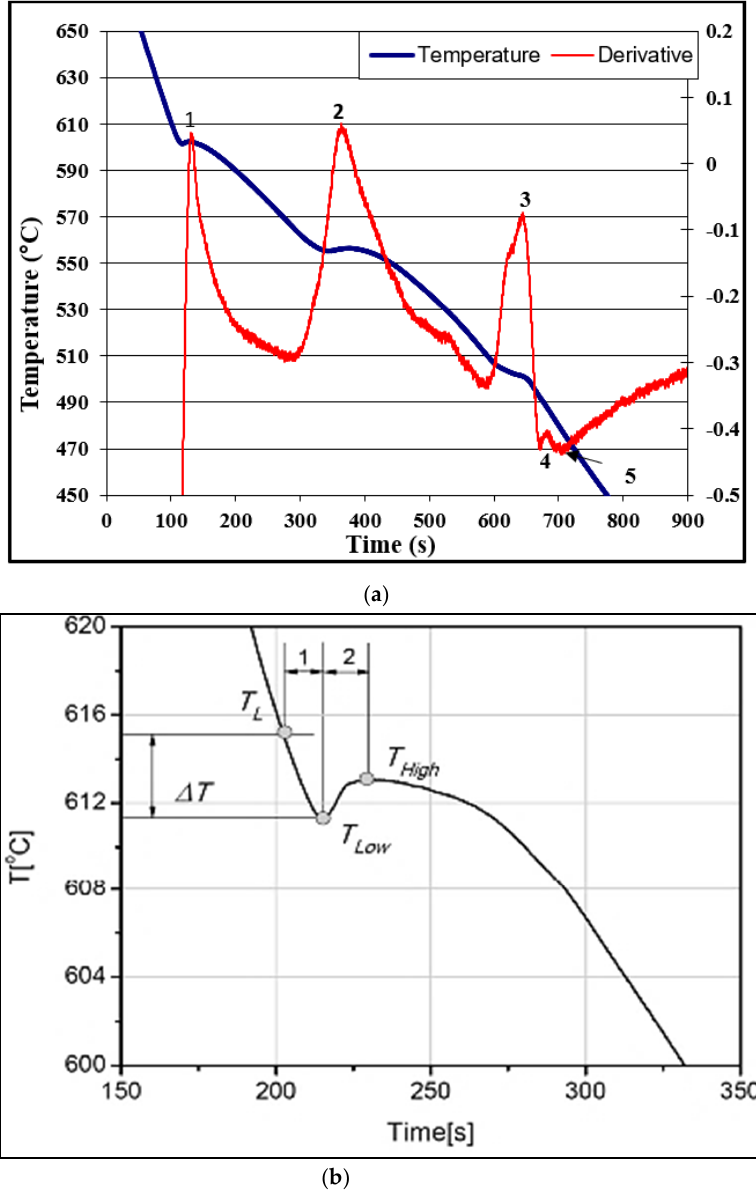
Figure 11. ( a ) Solidification curve and its first derivative ( ∆ T/ ∆ t) of C alloy (0.8 °C/s). ( b ) Schematic diagram of a solidification curve during the beginning of solidification: T L : liquidius temperature, T low : lowest temperature before recalescence, T high : highest temperature after recalescence, ∆ Tmaximum undercooling.